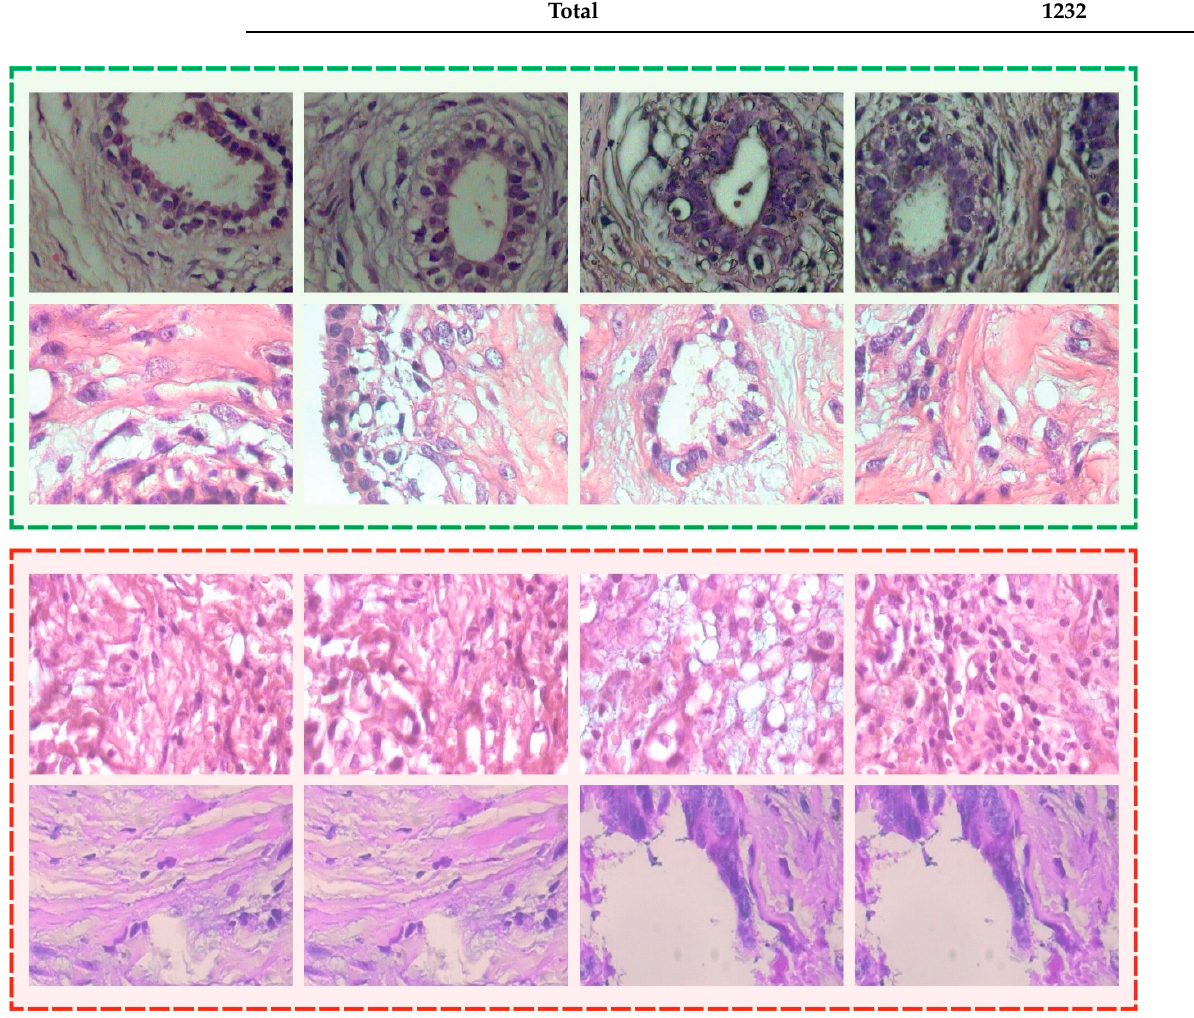
Figure 3. Sample images.